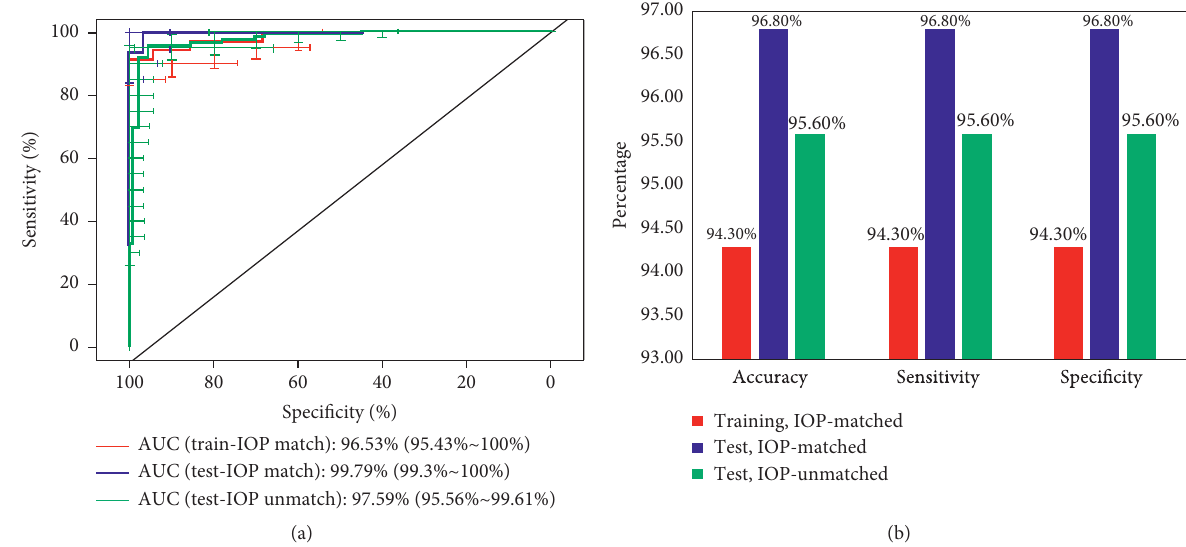
Figure 2: Representative graphs for ROC curves (a) and three evaluation indicators (accuracy, sensitivity, and specificity) (b) for NPS in both IOP-matched training set (35 keratoconus and 35 normal eyes), and IOP-matched (31 keratoconus and 31 normal eyes) and IOP- unmatched (112 keratoconus and 91 normal eyes)